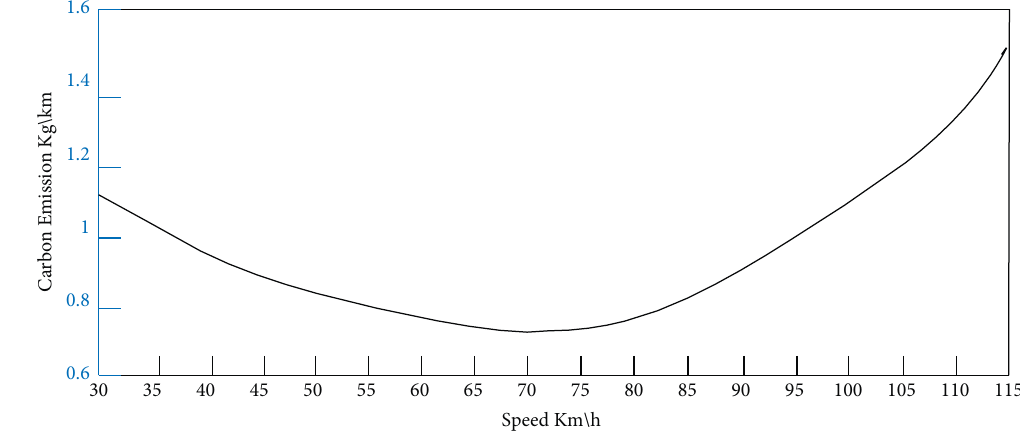
Figure 6: The impact of vehicle speed on carbon emission. Table 11: Analysis of interval time-varying sensitivity.